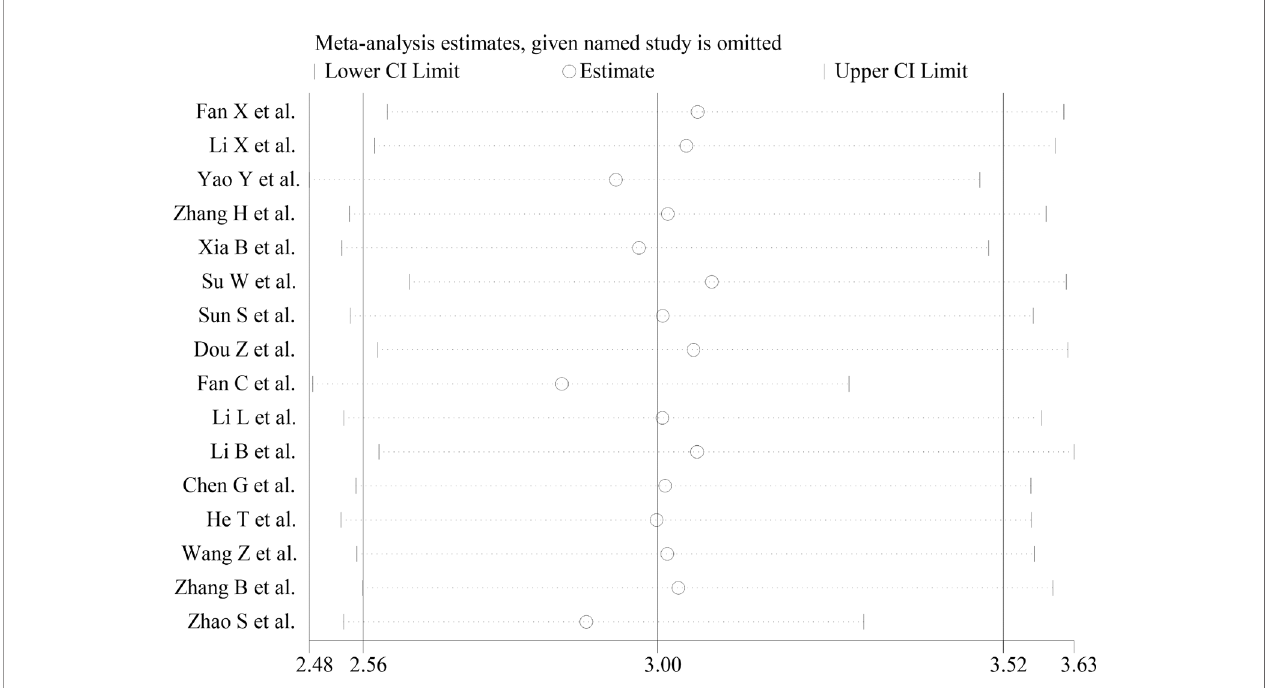
FIGURE 10 | Sensitivity analysis plot of overall included